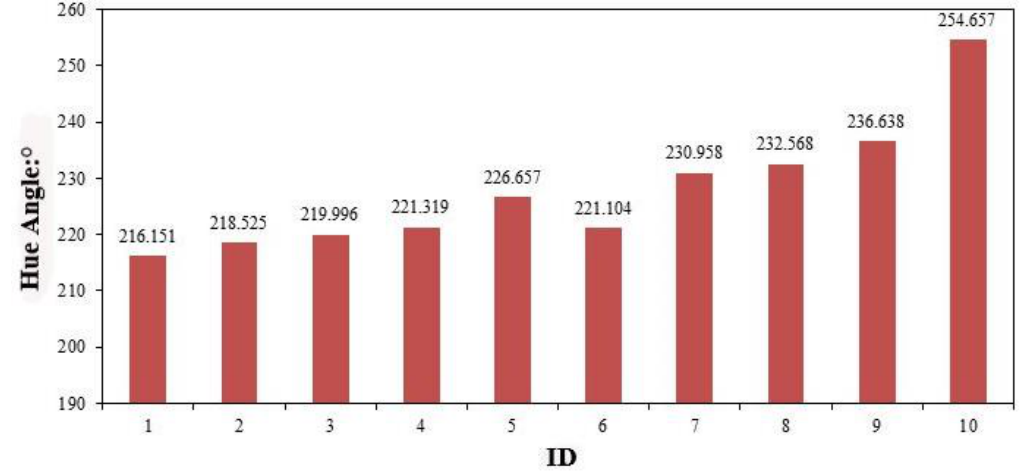
Figure 8. Result of the hue angles of ten water bodies in Qiqihar City.